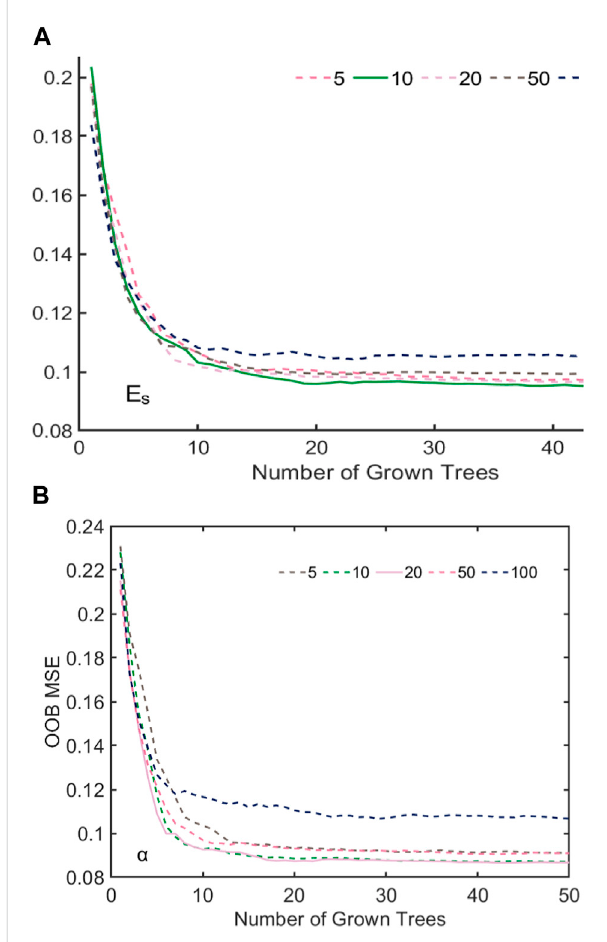
FIGURE 7 In fl uence of the number of trees and leaves on OOB MSE in the RF model: (A) for E s ; (B) for α